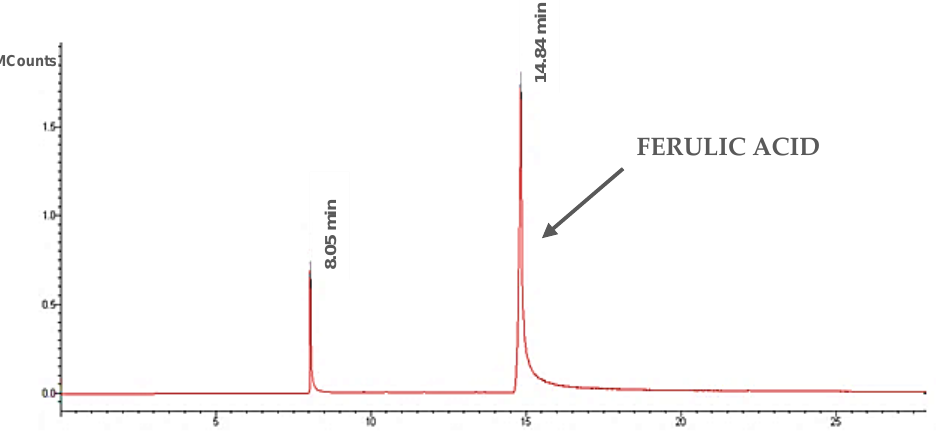
Figure 3. Chromatogram of ethanol extract of Ferula assa-foetida L.